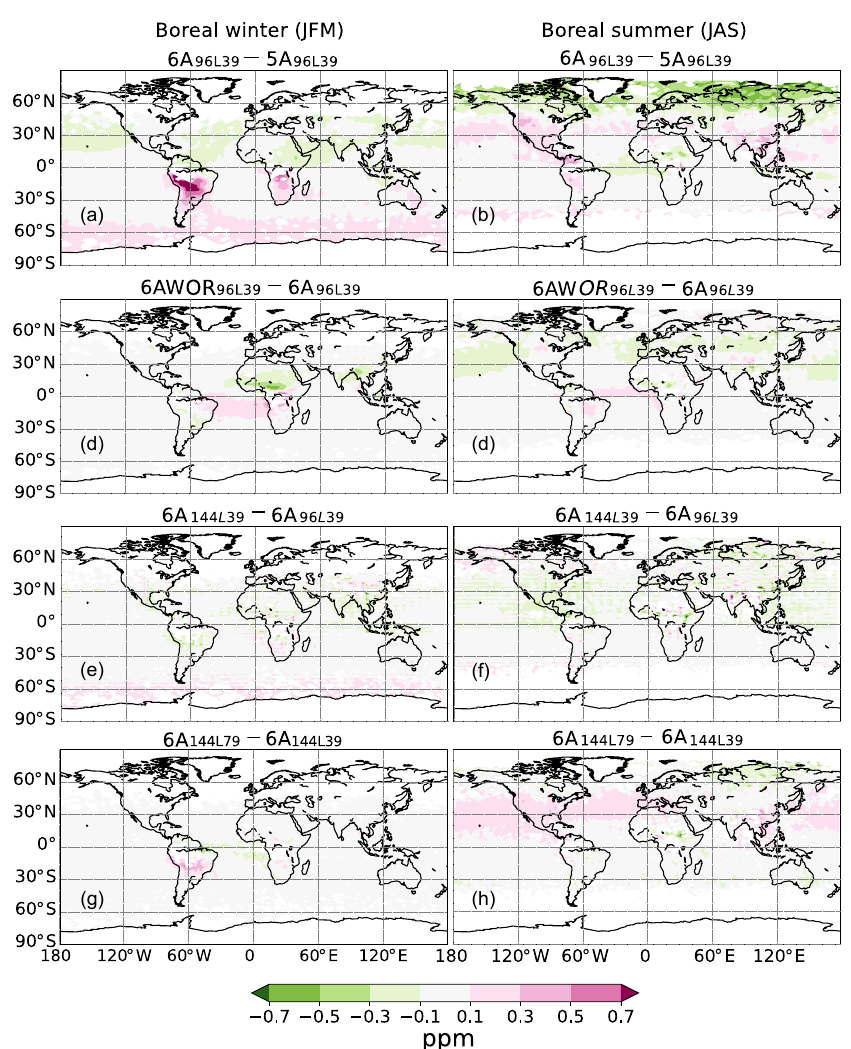
Figure 4. Map of the differences in xCO 2 (ppm) between 6A-96L39 and 5A-96L39 ( a, b , effect of the new physics), 6A-96-L39 and 6AWOR-96L39 ( c, d , effect of the land surface), 6A-144L39 and 6A-96L39 ( e, f , effect of the horizontal resolution) and 6A-144L79 and 6A-144L39 ( g, h , effect of the vertical resolution). The left column shows the average over the 2005–2010 boreal winters (December– February), and the right column shows the average over 2005–2010 boreal summers (June–August). The simulated xCO 2 values have been temporally convolved with the sampling of the OCO-2 satellite retrievals for the year